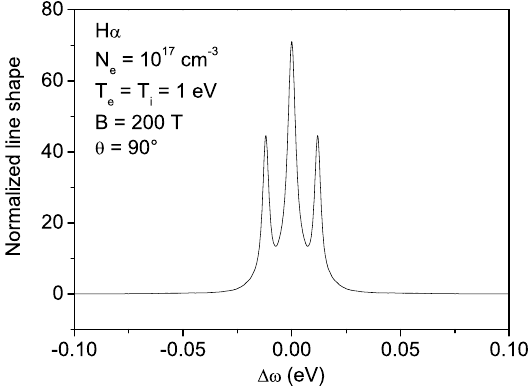
Figure 1. Plot of H α calculated at N e = 10 17 cm − 3 , T e = T i = 1 eV, with a magnetic field of 200 T. An observation direction perpendicular to the magnetic field has been assumed. The spectrum exhibits a clean Zeeman triplet structure.